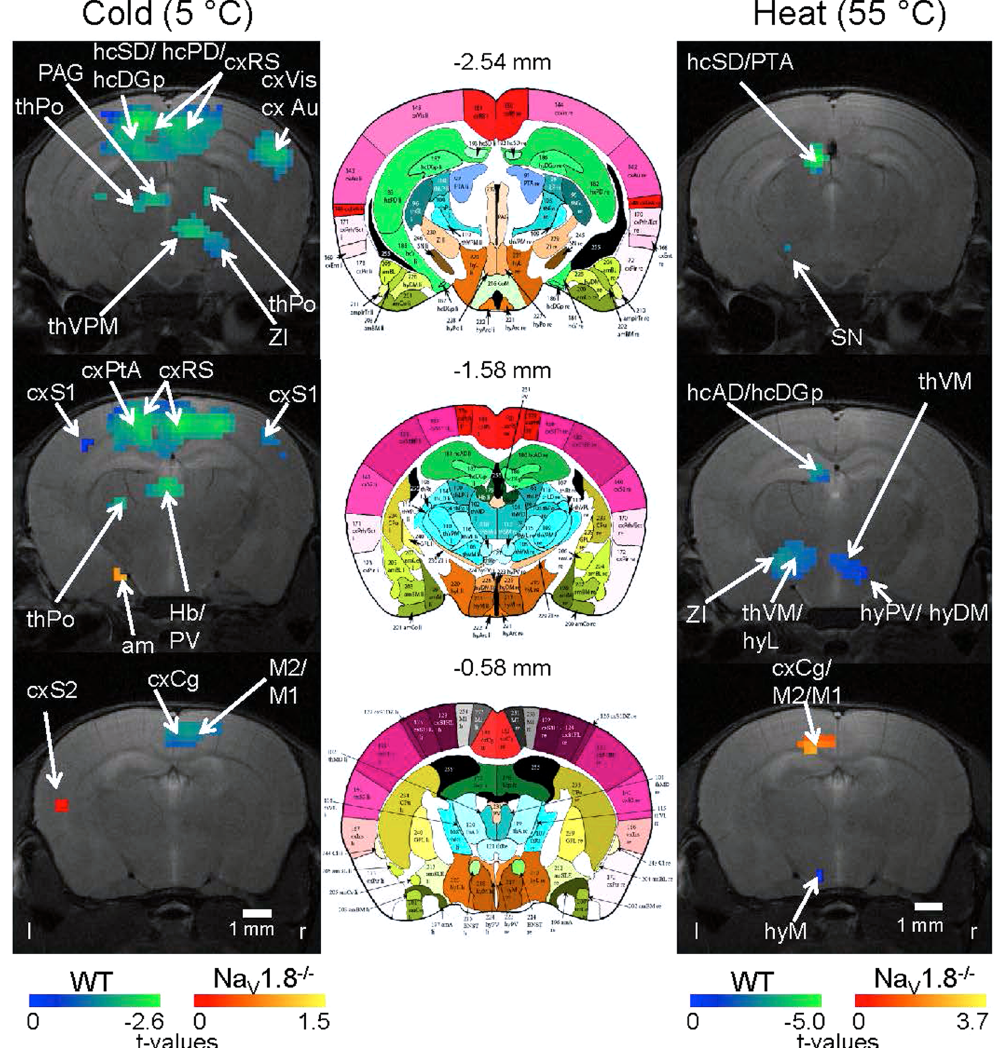
Figure 1. Second order statistics of activation maps of Na V 1.8 − / − and WT mice following cold and heat stimulation. Activation maps show differences in t-values (Na V 1.8 − / − and WT, see Materials and Methods) at voxels which are significantly different between WT and Na V 1.8 − / − mice upon cold (5 °C, left column) and heat (55 °C, right column) stimulation. The negative values (blue-to-green scale) indicate stronger activation in WT, the positive values (red-to-yellow scale) indicate stronger activation in Na V 1.8 − / − . Arrows point to brain structures which were identified by matching with the digital atlas (middle column). The numbers above the atlas slides indicate the respective bregma coordinate. For abbreviations see Supplementary